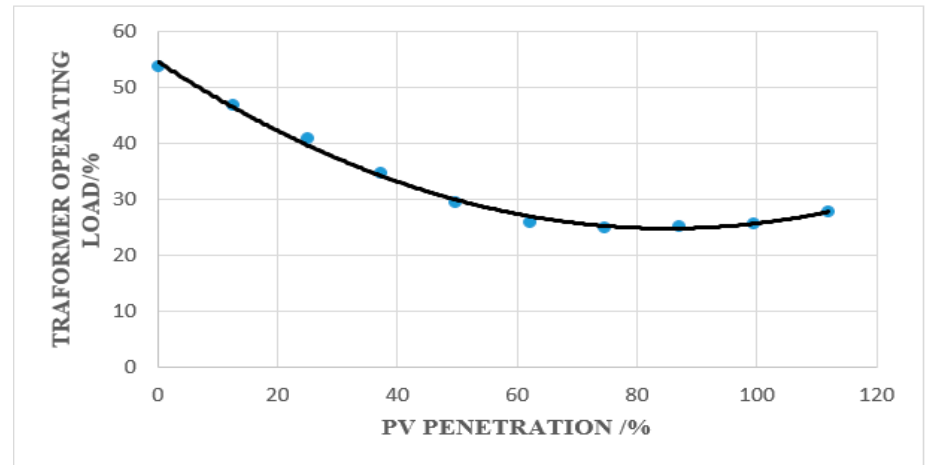
Figure 6. Graphical analysis of transformer percentage loading.